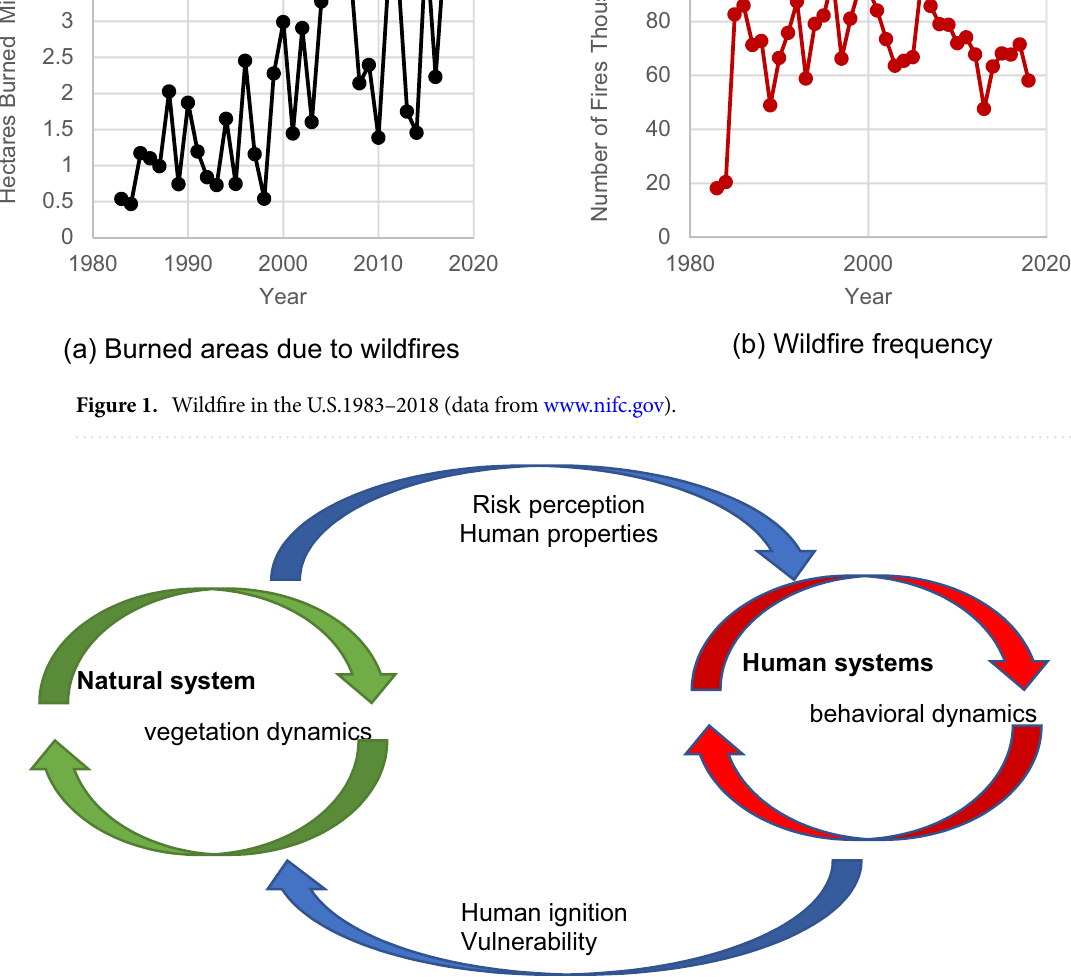
Figure 2. Our study framework of wildfire as an outcome of a coupled human-natural system (adapted from https:// www. nsf. gov/ pubs/ 2018/ nsf18 503/ nsf18 503. htm and adjusted for the case of